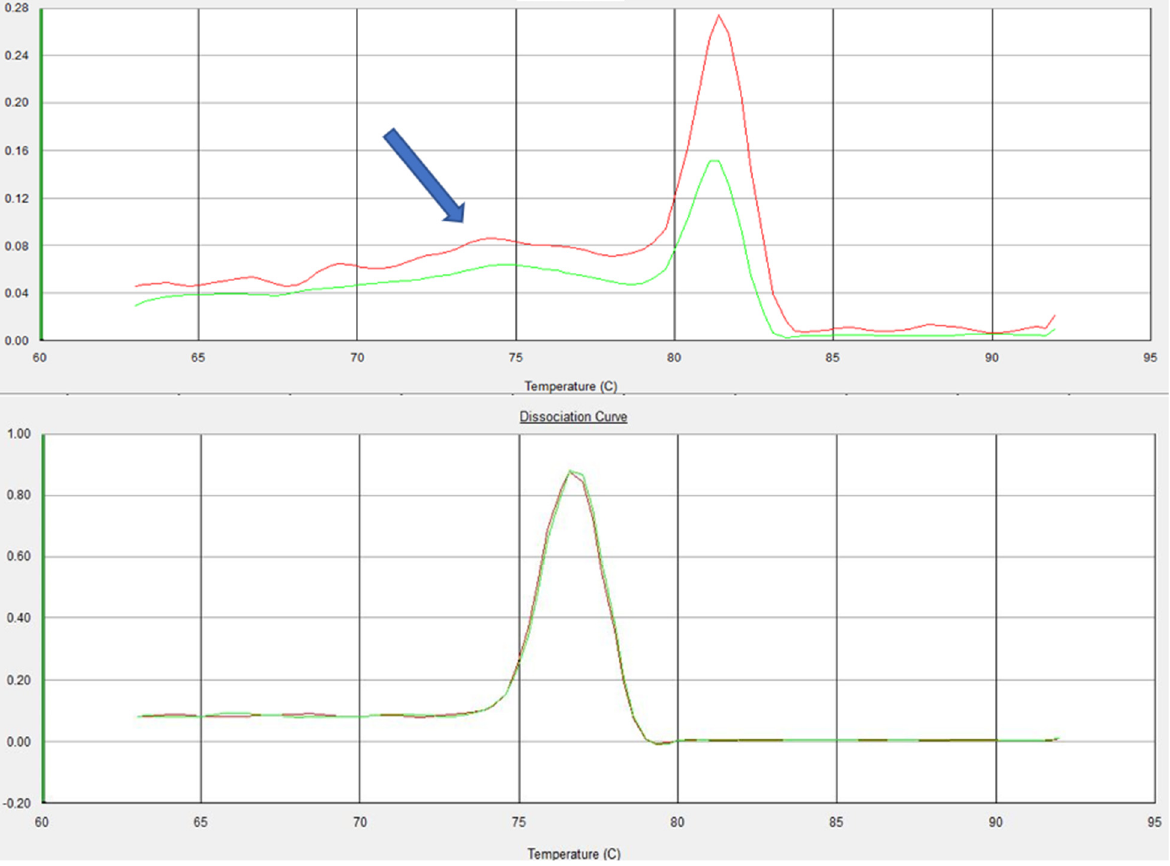
Figure 1. Melting curve plots displaying data collected during the melting curve analysis of tested primers. ( A ) Two peaks in the melting curve were observed during the analysis of the primer pair of the currently available assay, indicating non-specific amplification (Arrow). ( B ) Single specific peak was observed during the analysis of the newly designed primers, indicating the absence of any off-target